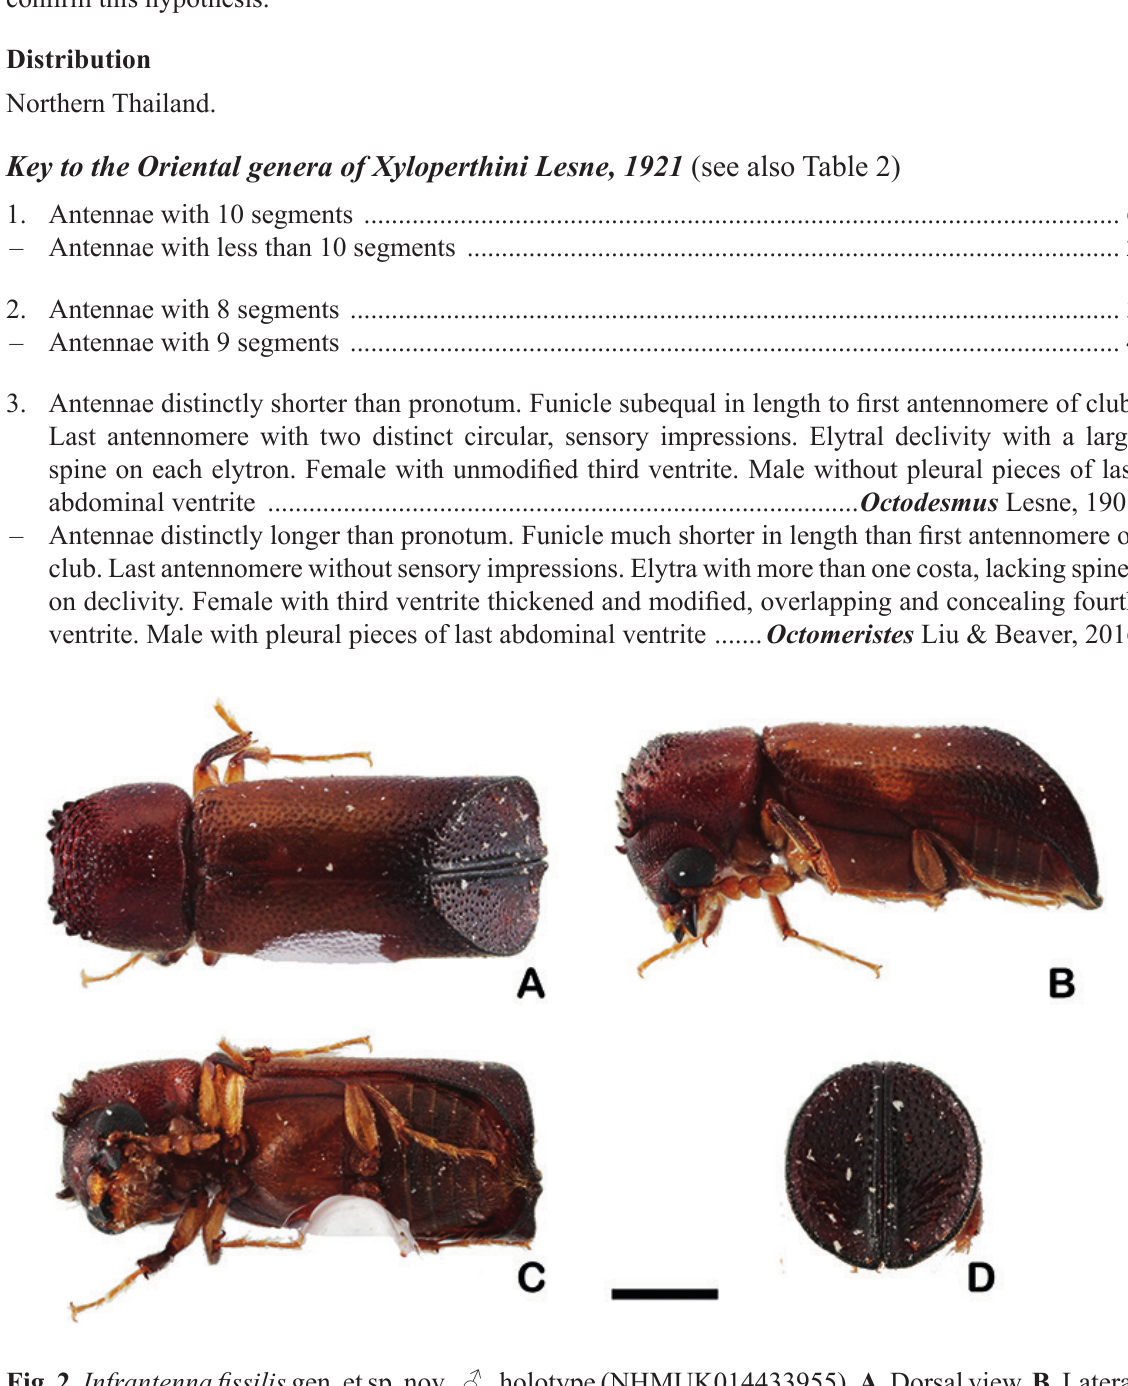
Fig. 2. Infrantenna fissilis gen. et sp. nov., ♂ , holotype (NHMUK014433955). A . Dorsal view. B . Lateral view. C . Ventral view. D . Declivity. E . False epipleuron. Scale bar = 1